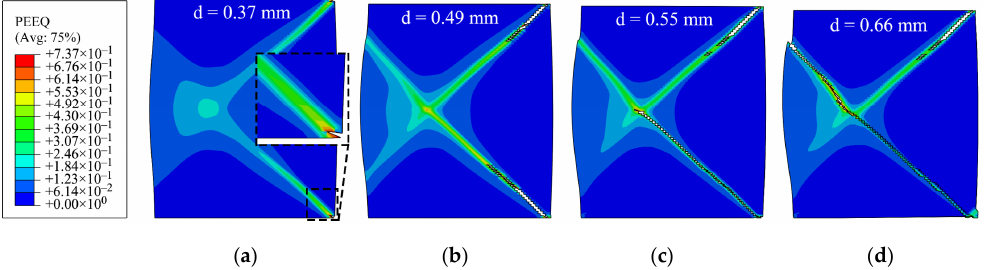
Figure 6. Sequence of crack propagation in a typical compressed ring specimen: ( a ) formation of shear bands and crack initiation at the corner of outer wall; ( b ) crack propagates along the shear bands; ( c ) crack reaches the center of the cross-section; and ( d ) crack reaches the inner wall (complete rupture). The stroke of the top platen, d , is shown above the models.